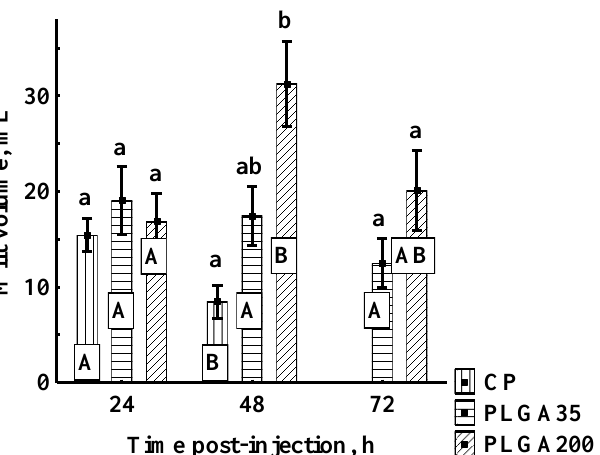
Figure 4. Milt volume after hormone treatment. Significant differences among groups at a sampling point are indicated by lowercase letters ( p < 0.05). Significant differences within an experimental group are indicated by uppercase letters ( p < 0.05). Experimental treatments: CP — carp pituitary extract, dose 4 mg/kg; PLGA35 — Alarelin, dose 35 µg/kg; PLGA200 — Alarelin, dose 200 µg/kg.